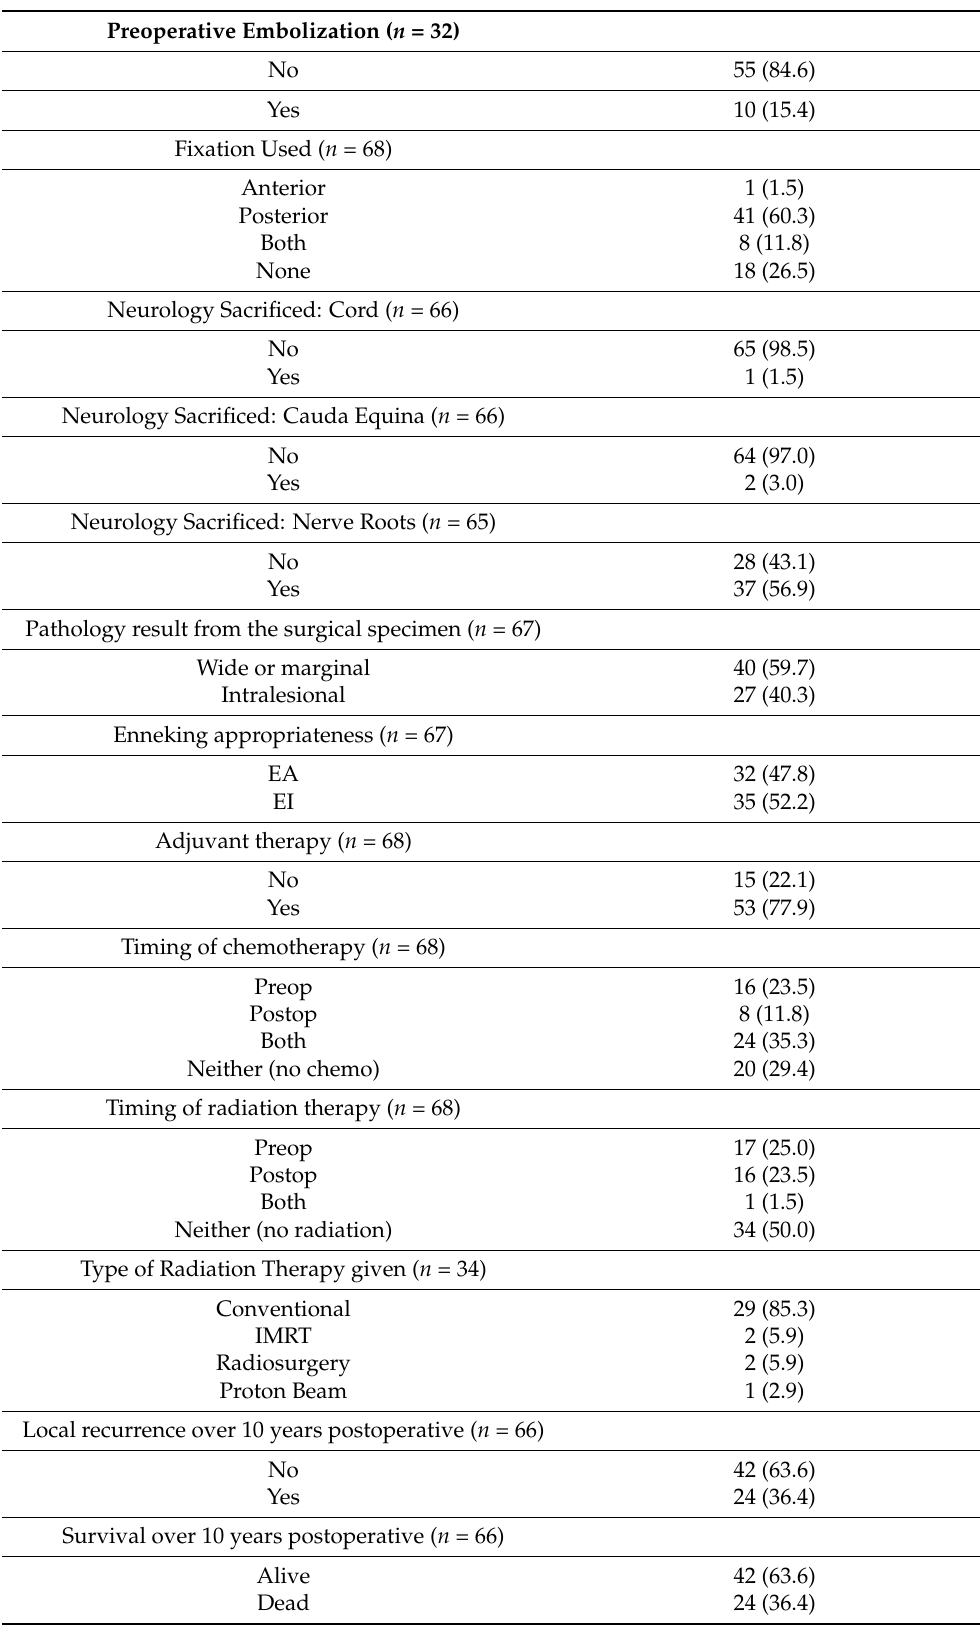
Table 3. Summary of treatment